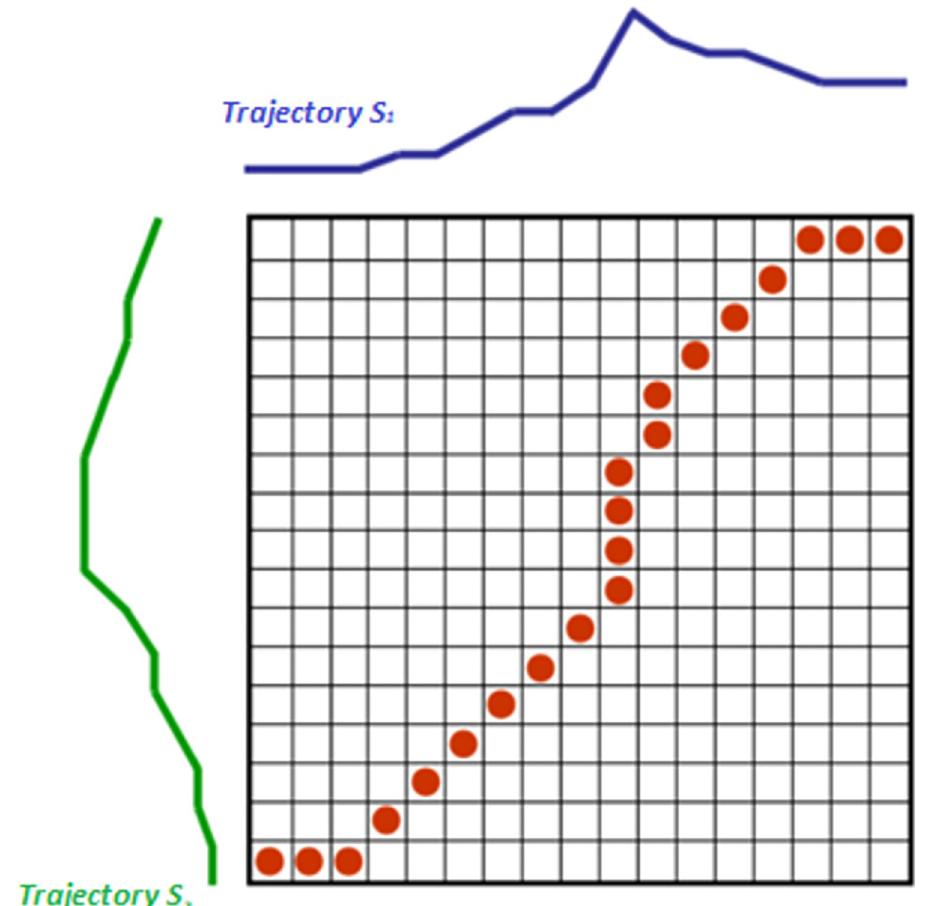
Fig 1. Visualising DTW. Two sample trajectories are analysed with the distance matrix provided. The optimal pathing may be found, represented by the red dots, which are alignment of the two trajectories (Anderberg, 1973).